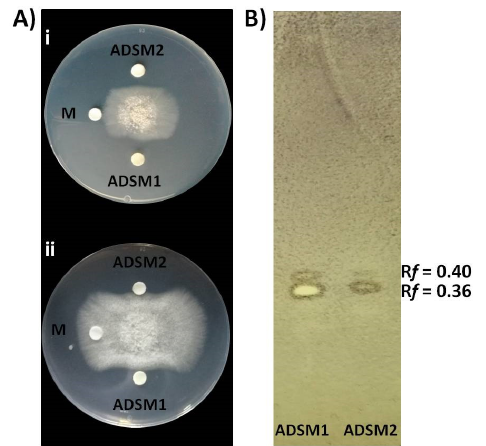
Figure 7. Inhibitory effect of agar-diffusible secondary metabolites (ADSM) of Cal.l.30 against B. cinerea . ( A ) Confrontation well-diffusion assay at 3 d ( i ) and 6 d ( ii ) of interaction. ADSM1 and ADSM2 represent agar-diffusible secondary metabolites of Cal.l.30 when grown singly and together with B. cinerea , respectively, while M is the solvent of methanol used as negative control. ( B ) TLC-bioautography using ADSM1 and ADSM2 of Cal.l.30.